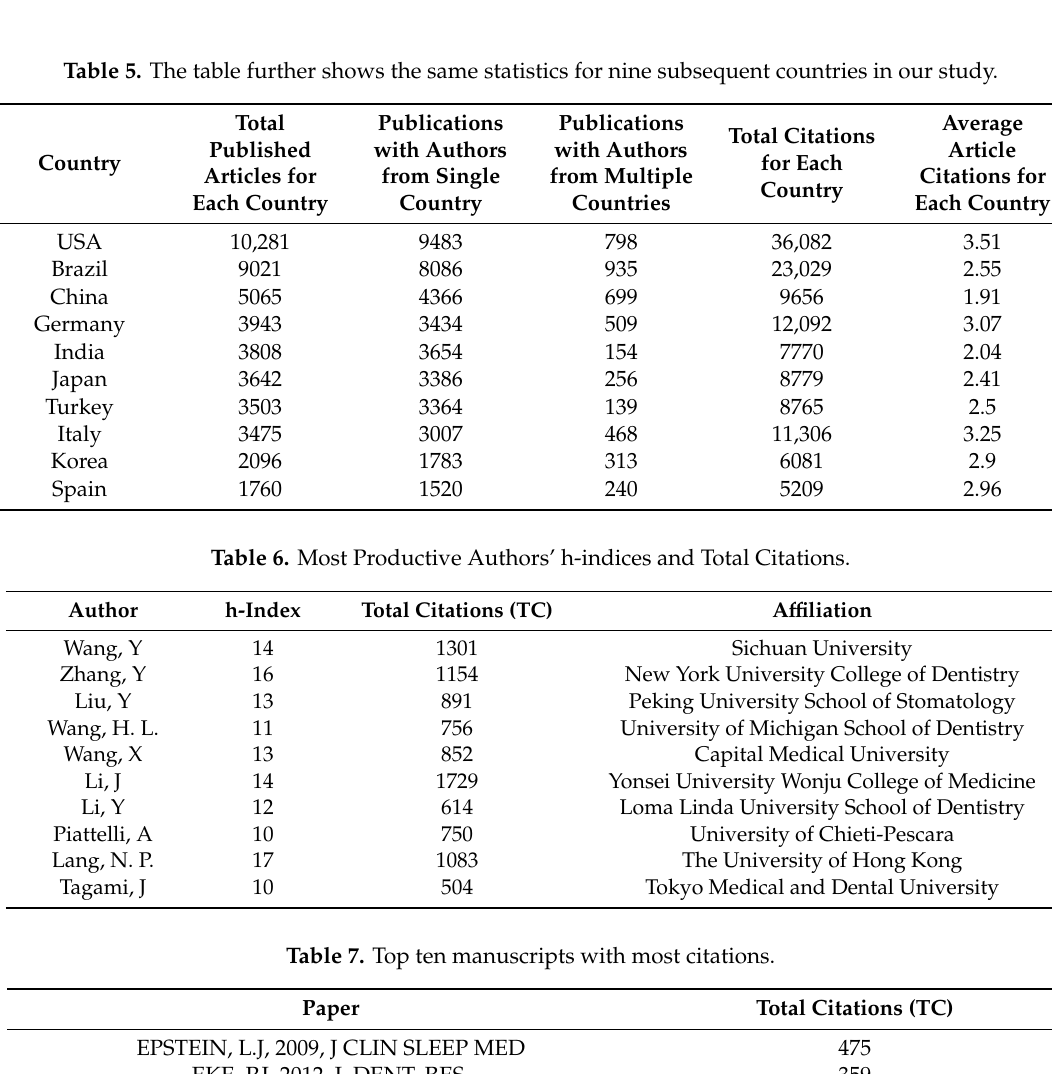
Table 5. The table further shows the same statistics for nine subsequent countries in our study.